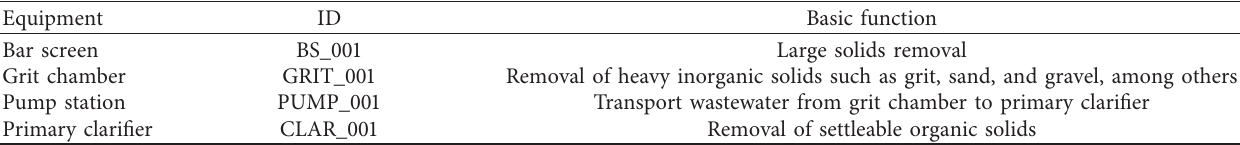
Table 2: Preliminary treatment process information.